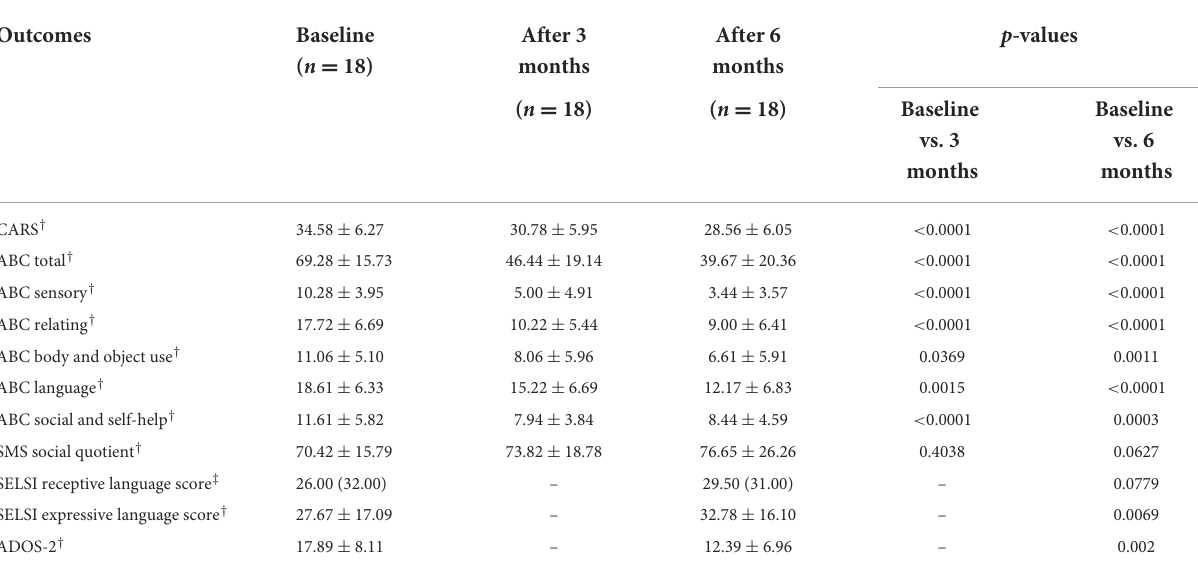
TABLE 3 Changes in outcome measures.